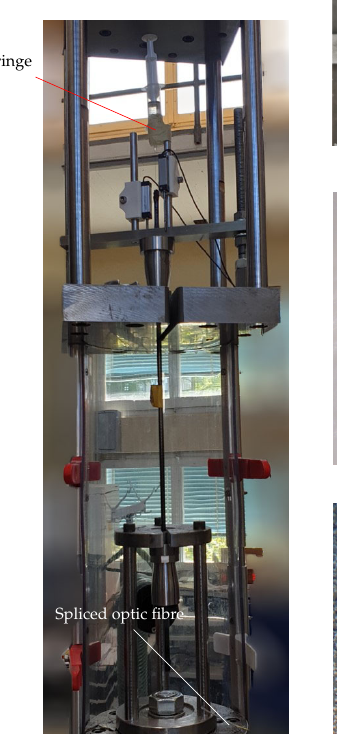
Figure12. Tensiletestingofanchoredsample The strain distribution along one test sample with a total length of 0.6m and wedge 263 anchors at both ends is shown in Figure 13. In general, the strain distribution curves have 264 Figure 12. Tensile testing of anchored sample. ( a ) Setup for the fiber optic measurement; ( b ) prepared relatively good quality, which is due to the integration of the DFOS into the tendon. Corre- 265 end of a CFRP tendon; ( c ) eccentricity of 1.4 mm of the optical fiber; ( d ) optical fiber with core and lation losses are not significant. In addition, the strain in the free length is constant. Also 266 the left anchor and the right one show similar patterns. The different curves correspond to 267 coating embedded in different load levels. The zero measurement was taken before pressing in the wedge into 268 the barrel. The strain after setting the wedge is in the range of 2000 µ m . This stretching is 269 caused by the radial pressure, which acts on the tendon. The anchorage length increases 270